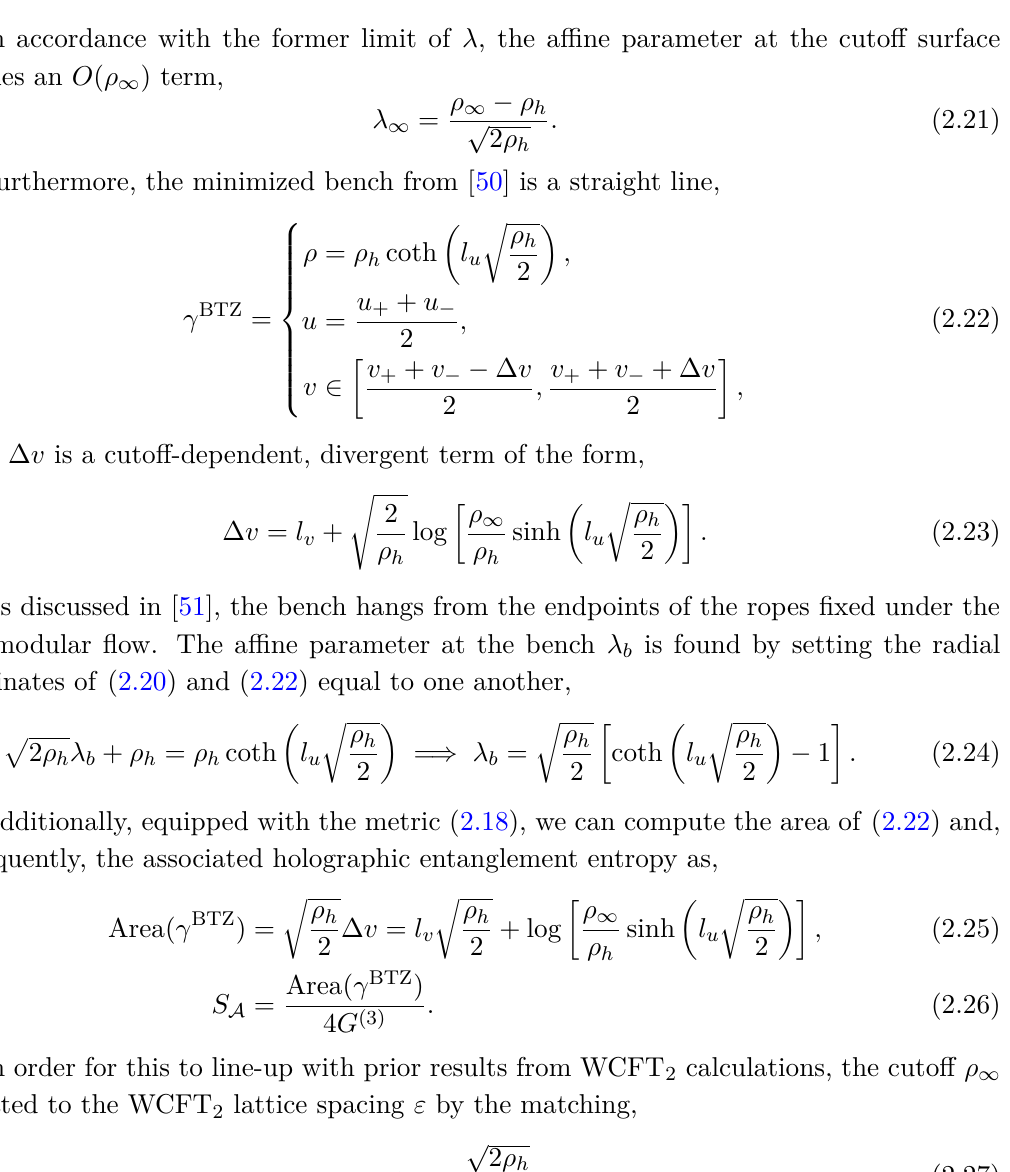
symmetry which proves useful 2